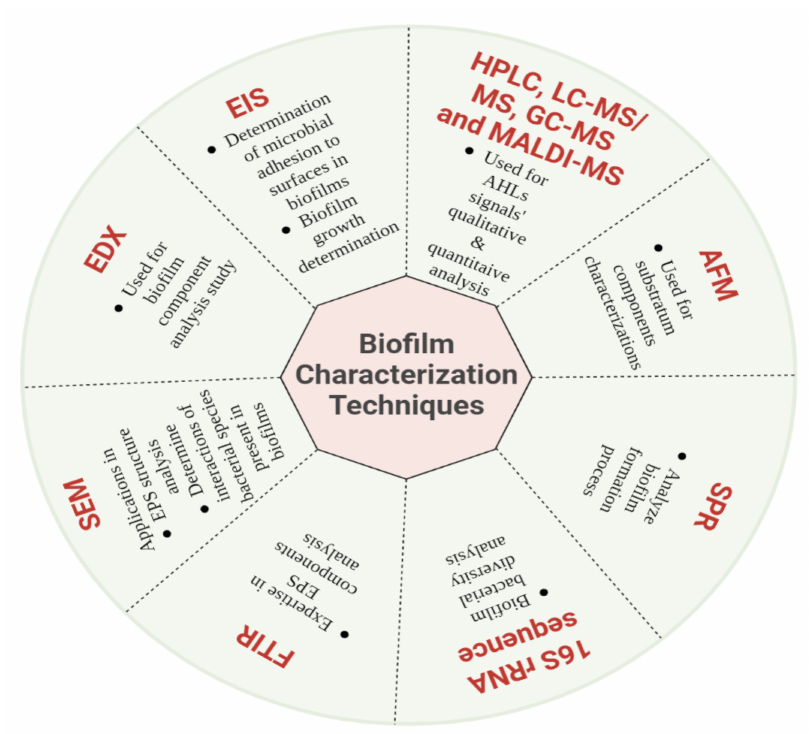
Figure 2. Schematic diagram of various techniques used for biofilm